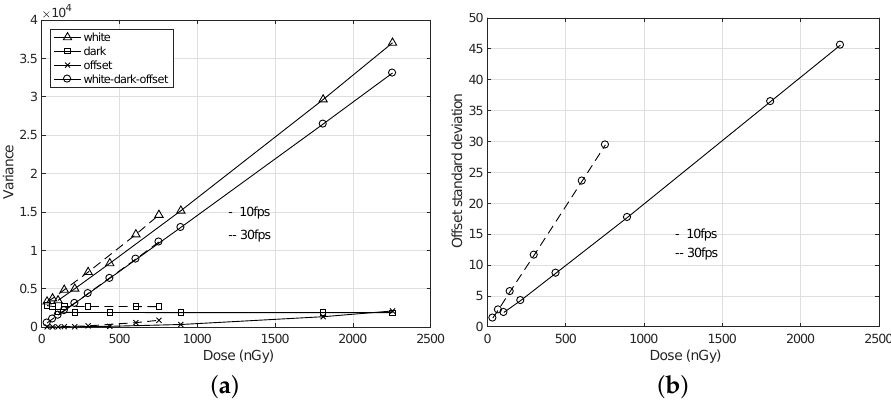
Figure 3. Observation of the photon noise and the exposure leak for a dynamic detector in Figure 1. Both the variance electric noise and variance offset are extracted from the variances of the white images to observe a linearity of the photon noise with respect to the incident dose. ( a ) Variance curves; ( b ) Standard deviation curves of the variance offset.